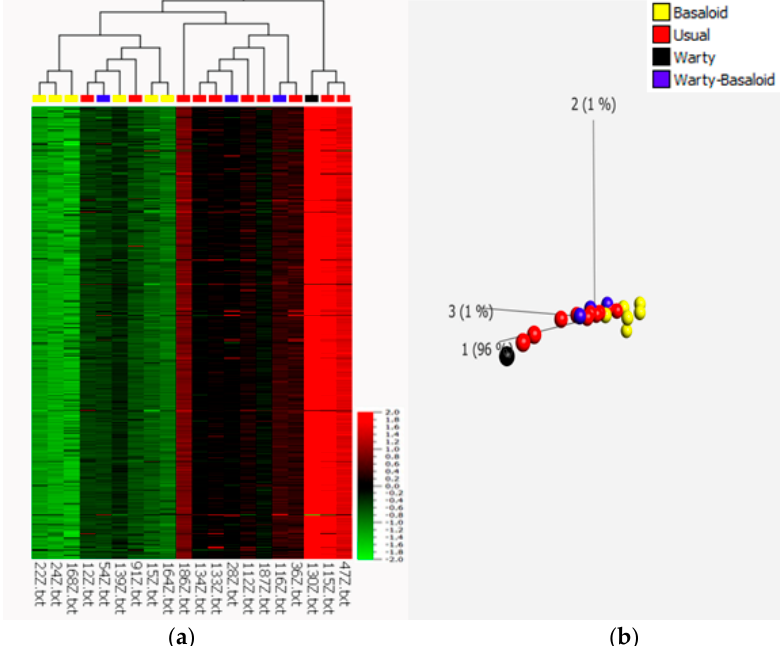
Figure 2. Multiple group comparison of differentially expressed miRNAs in basaloid, warty–basaloid, warty, and usual histological subtypes using the F-test ( q ≤ 0.01). ( a ) Heatmap; ( b ) principal component analysis